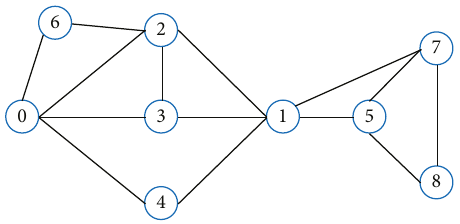
Figure 2: An example network with 8 nodes and 13